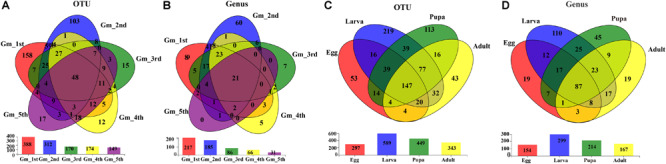
Venn diagrams depicting the overlap of the bacterial community at OTU and genus levels. (A) OTU level at the larval stage of G. molesta. (B) Genus level at the larval stage of G. molesta. (C) OTU level in the life cycle of G. molesta. (D) Genus level in the life cycle of G. molesta. Abbreviations: Gm = Grapholita molesta, 1st = first instar, 2nd = second instar, 3rd = third instar, 4th = fourth instar, 5th = fifth instar, FP = female pupa, MP = male pupa, FA = female adult, and MA = male adult.